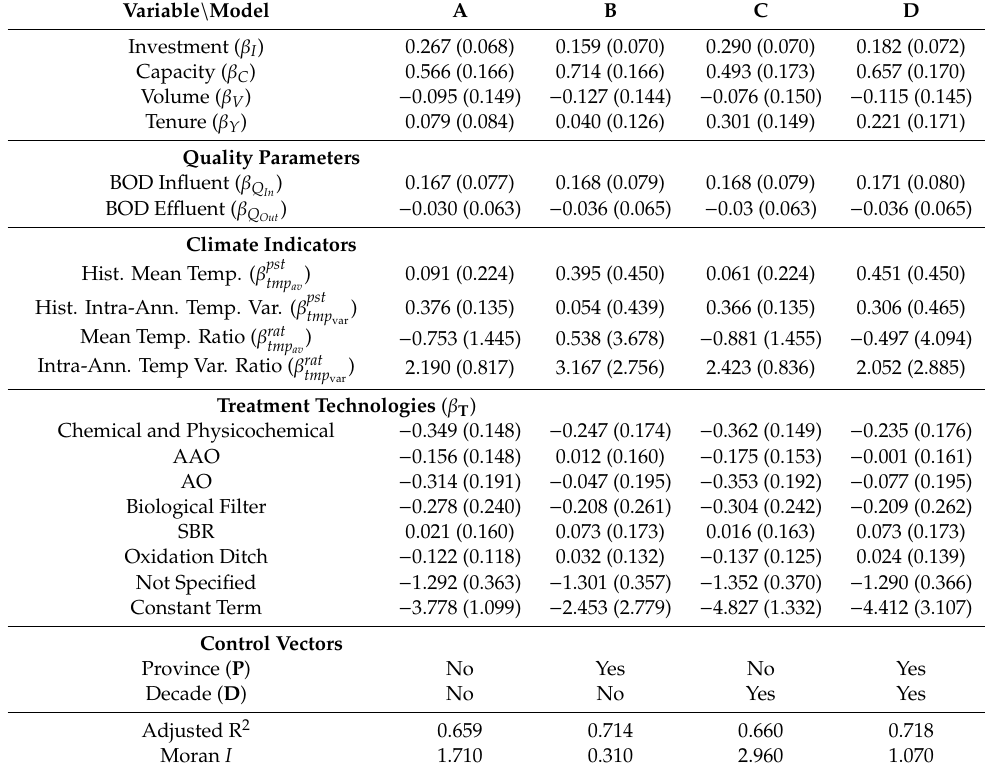
Table 4. Estimated coe ffi cients for O&M cost equation under di ff erent